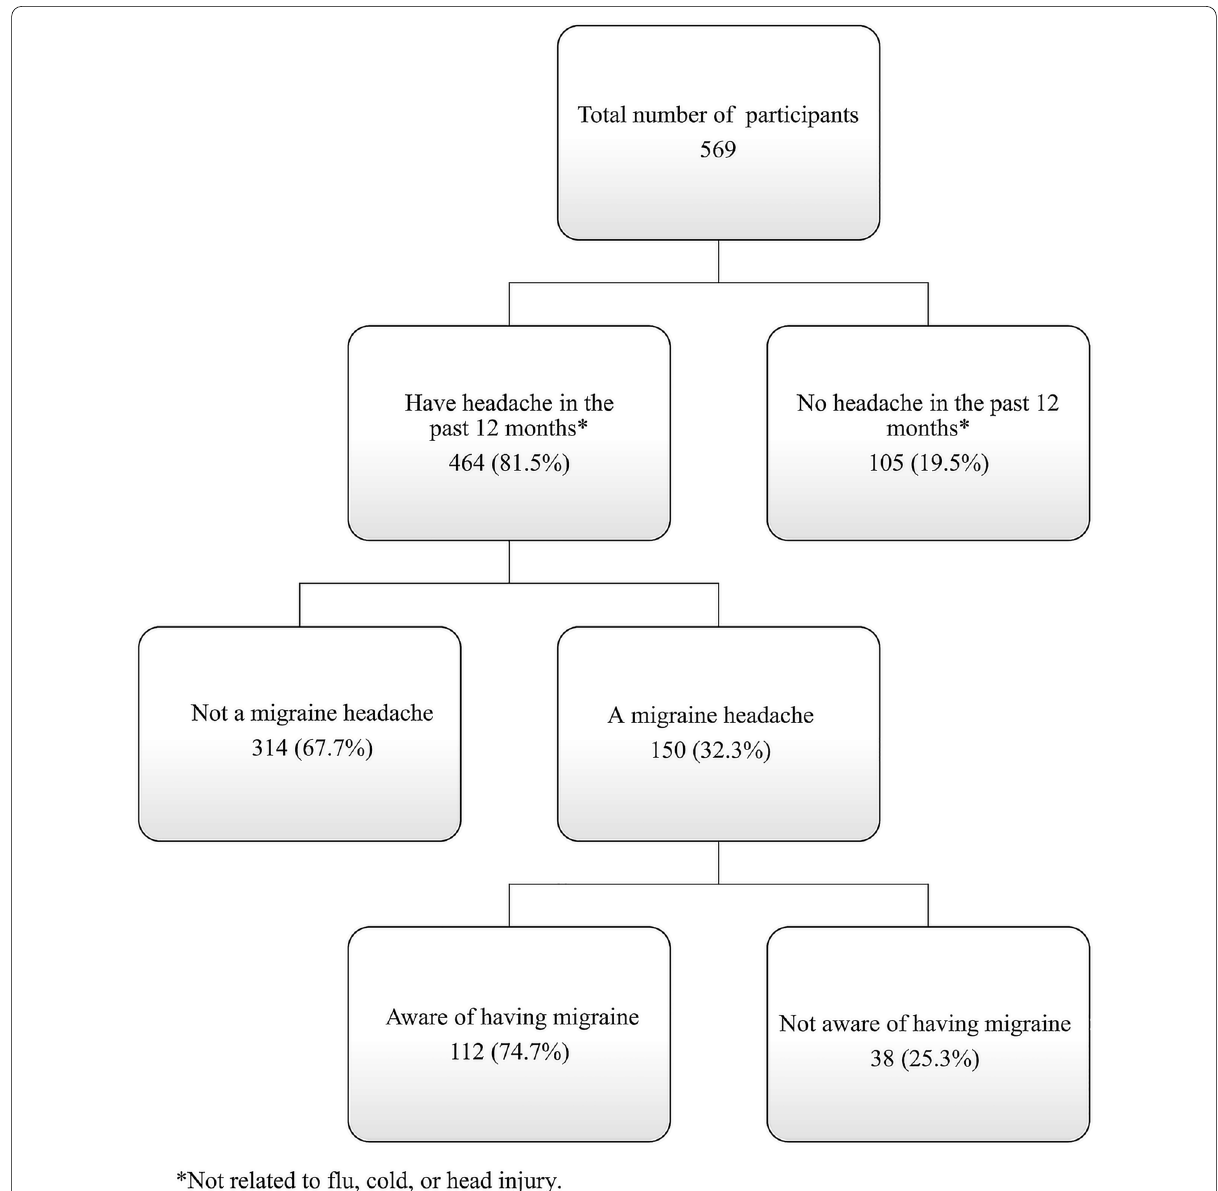
Fig. 1 Flowchart of the study participants. *Not related to flu, cold, or head